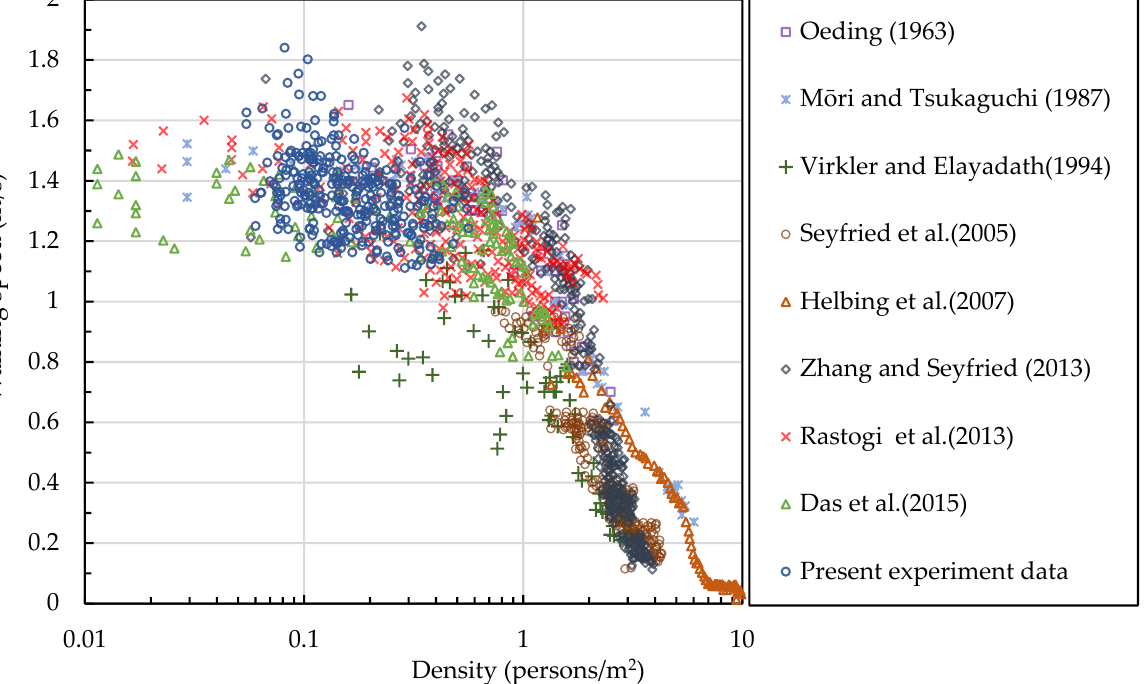
Figure 9. Macroscopic fundamental diagram of speed–density relationship from experimental and observational data [27 – 34].